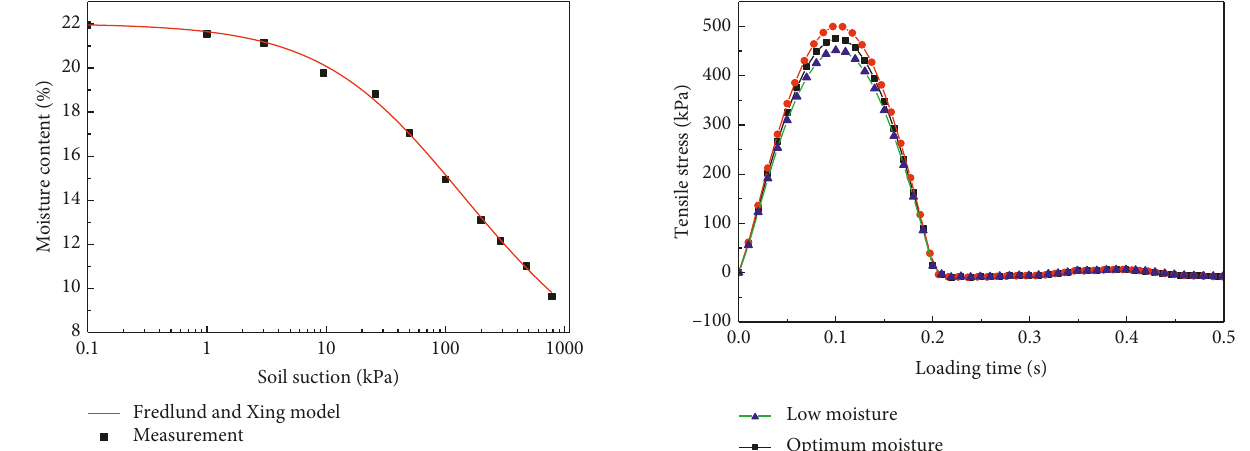
Figure 6: SWCC test and fitting curve of subgrade soils. Table 3: Fitting parameters for SWCC test.